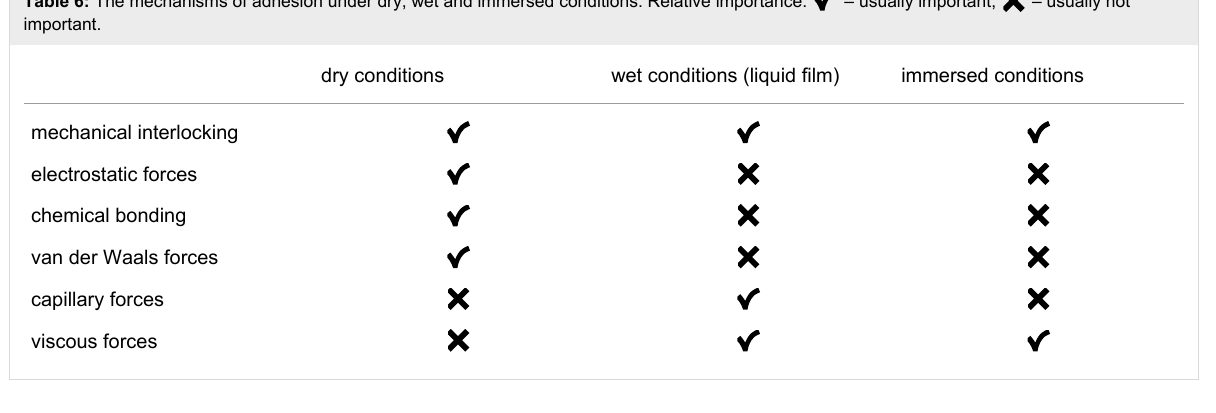
Table 6: The mechanisms of adhesion under dry, wet and immersed conditions. Relative importance: